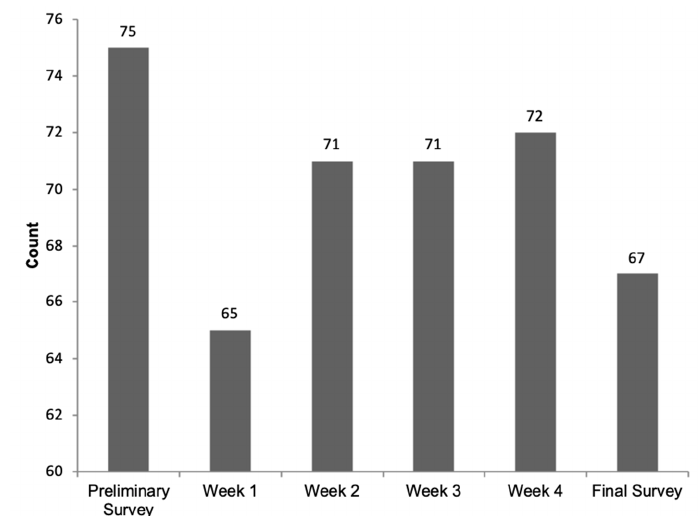
Figure 3. Total responses to each survey contact for woodland association members only.